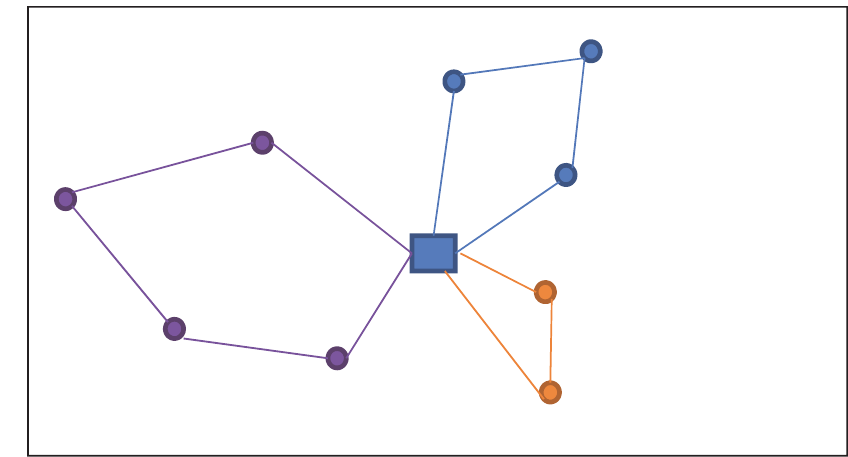
Fig. 2 . A graphical solution corresponding to the solution